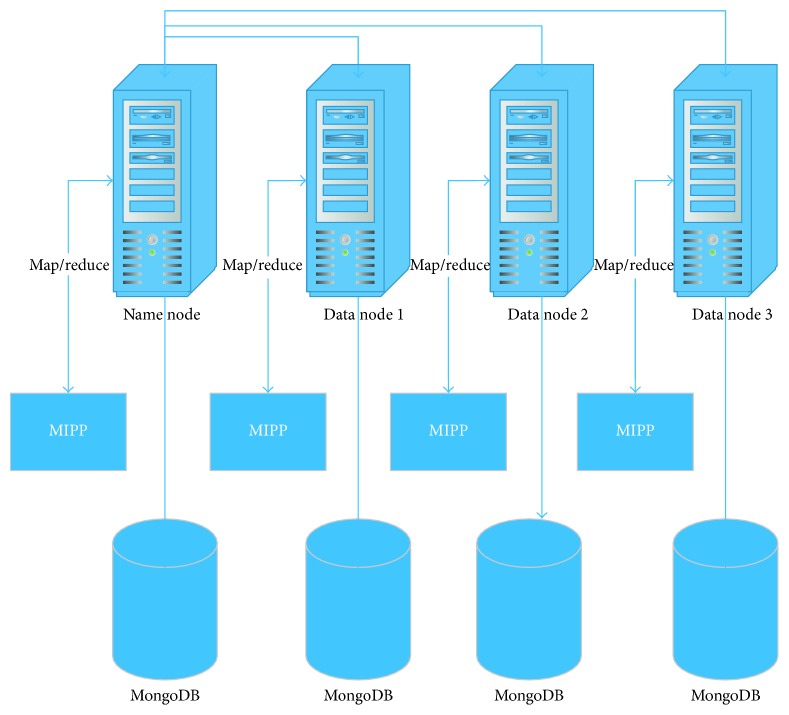
System architecture.